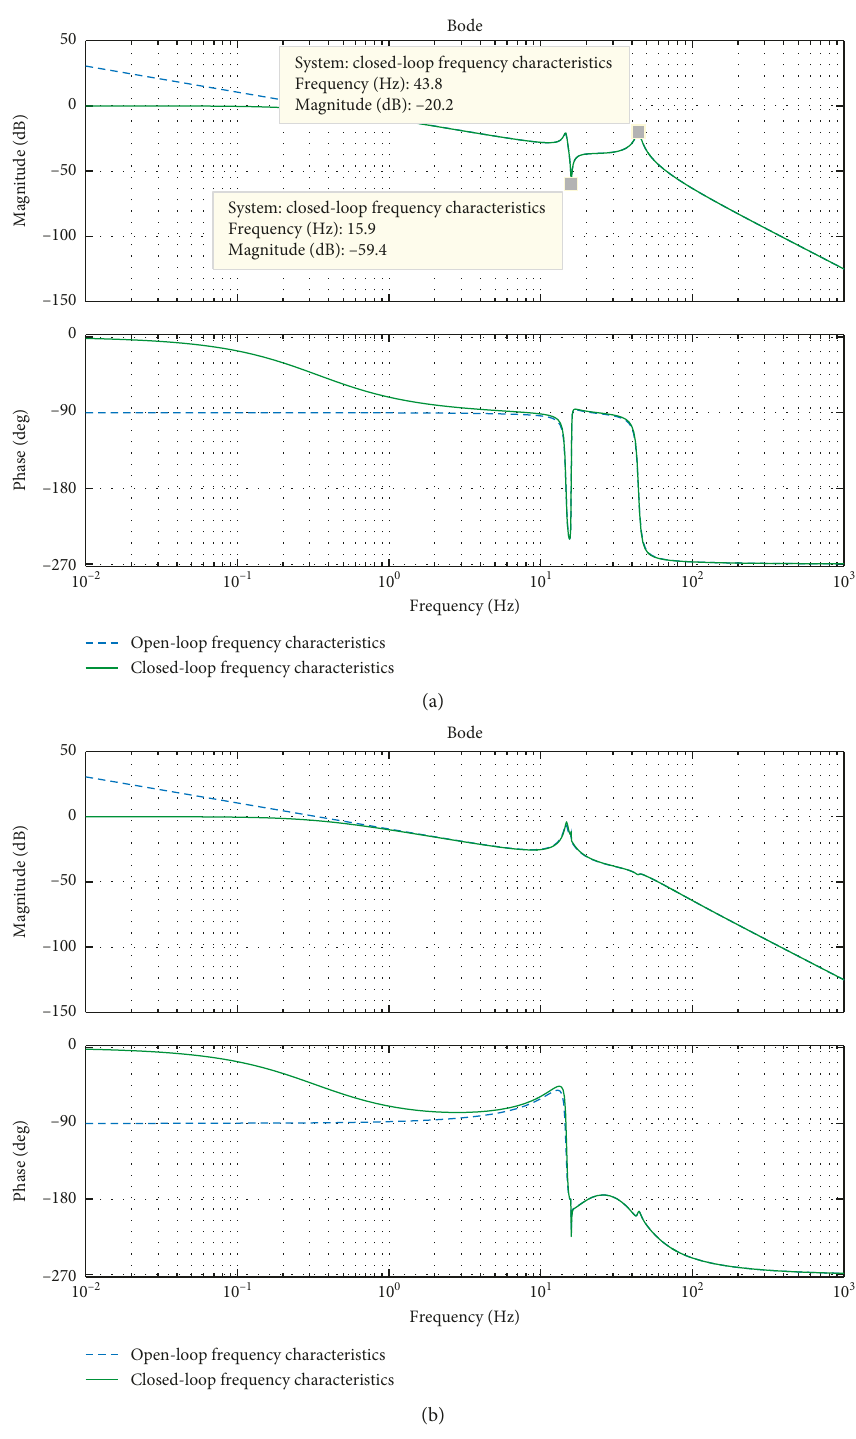
Figure 7: Frequency characteristic diagrams of the system: (a) before resonant suppression; (b) after resonant valley